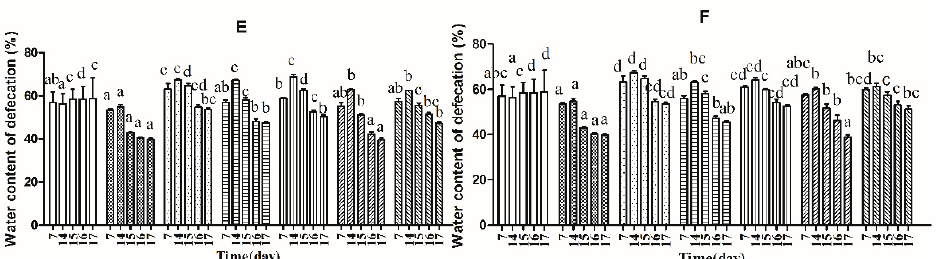
Figure 2. Defecation status of mice during experiments in eight BALB/c mice in each group. Phenolphthalein: 10 mg/kg body weight; 626: B. adolescentis CCFM 626; 667: B. adolescentis CCFM 667; 669: B. adolescentis CCFM 669; ST-III: Lactobacillus plantarum ST-III; High dose: 1 × 10 10 colony-forming units (CFU); Low dose: 1 × 10 8 CFU. ( A , C , E ) High-dose groups; and ( B , D , F ) low-dose groups. Mean values with different letters (a–g) over bars are significantly different ( p < 0.05) according to one-way analysis of variance and Duncan’s multiple range test.